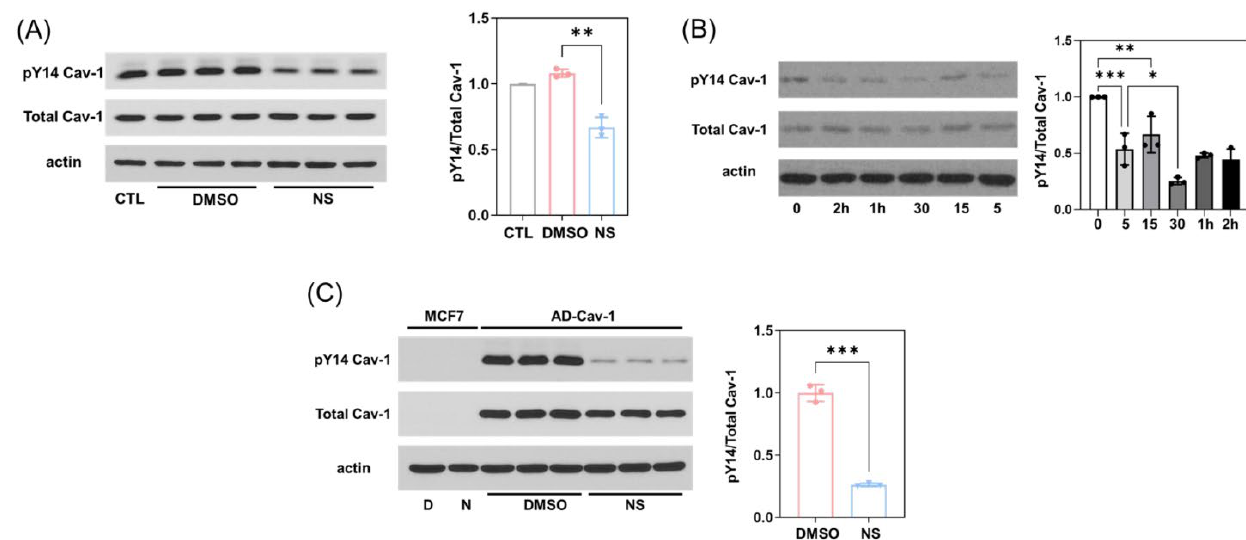
Figure 2. Kv11.1 activator NS1643 promotes dephosphorylation of Cav-1 but not through inhibition of Src activity. ( A ) MDA-MB-231 cells treated with DMSO or 50 μM NS1643 for 24 h were lysed and subjected to Western blotting. The treatment of NS1643 significantly reduced the phosphorylation level of Cav-1 without changing the total Cav-1 protein level. ( B ) MDA-MB-231 cells treated with 50 μM NS1643 for 0, 5, 15, or 30 min, or 1 or 2 h were collected, lysed, and subjected to Western blotting. The reduction in phosphorylation of Cav-1 induced by NS1643 was observed at 5 min and intensified over time. * p < 0.05, ** p < 0.005, *** p < 0.001 via ANOVA. ( C ) MCF-7 cells infected with adenovirus encoding Cav-1 were treated with DMSO or 50 μM NS1643 for 24 h, and then lysed and subjected to Western blotting. NS1643 significantly reduced the phosphorylation level of exogenously expressed Cav-1. n = 3; *** p < 0.001 via t test. All data are mean ± SD.